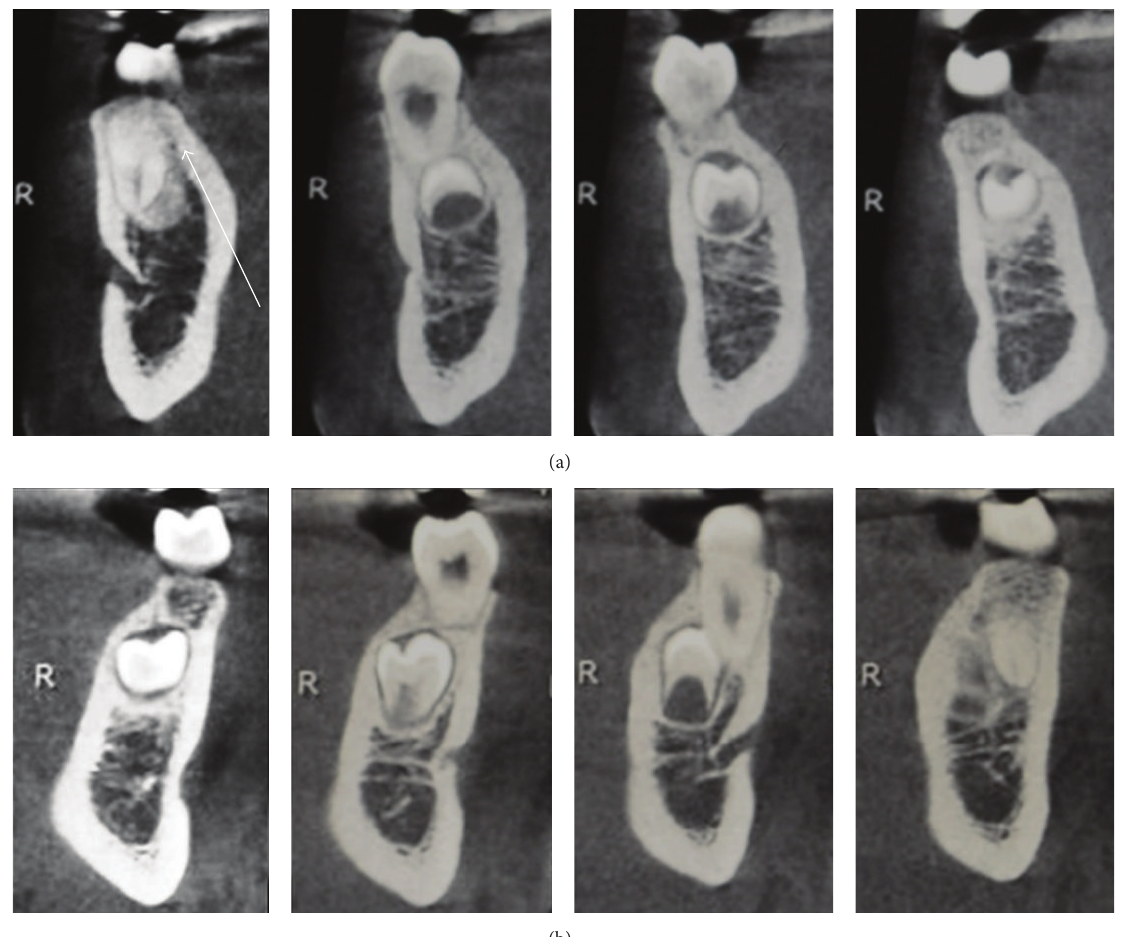
Figure 7: Case 4 CBCT: root resorption of contiguous teeth, indicated by the white arrows ((a) 4.3–4.4 and (b)